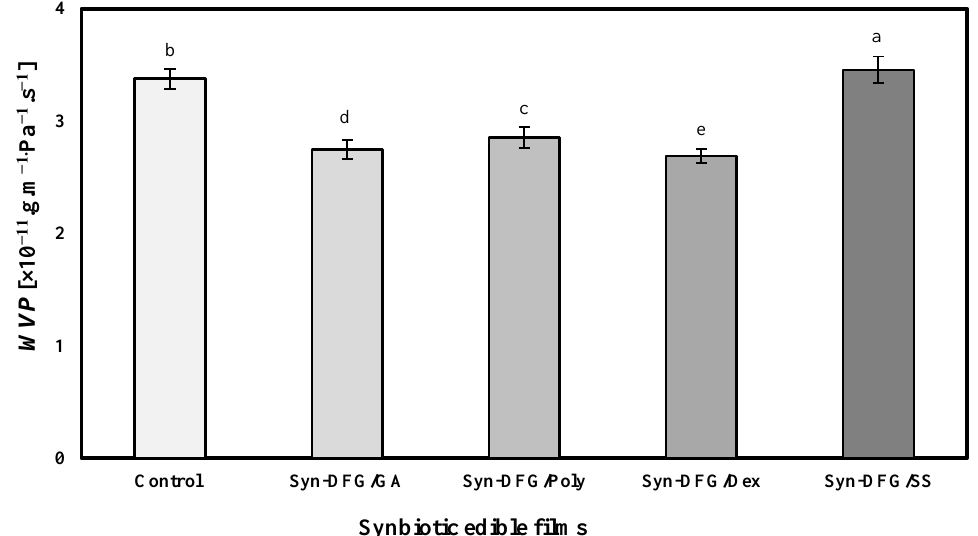
Figure 5. Water-vapor permeability of synbiotic edible films. a–e: Different letters on each column indicate significantly different values ( p < 0.05) following Duncan’s post hoc means-comparison